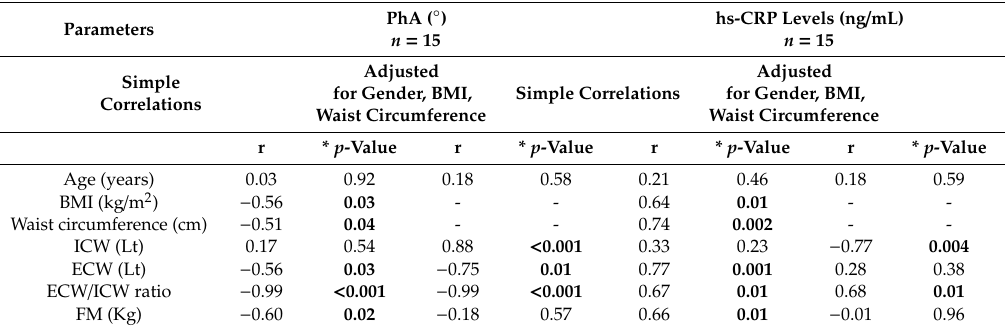
Table 2. Correlations, simple and after adjustment for gender, BMI, and waist circumference, among PhA and hs-CRP levels with age and anthropometric measurements in PWS adults. PhA ( ◦ ) hs-CRP Levels (ng / mL) Parameters n = 15 n = 15 Adjusted Adjusted Simple for Gender, BMI, Simple Correlations for Gender, BMI, Correlations Waist Circumference Waist Circumference